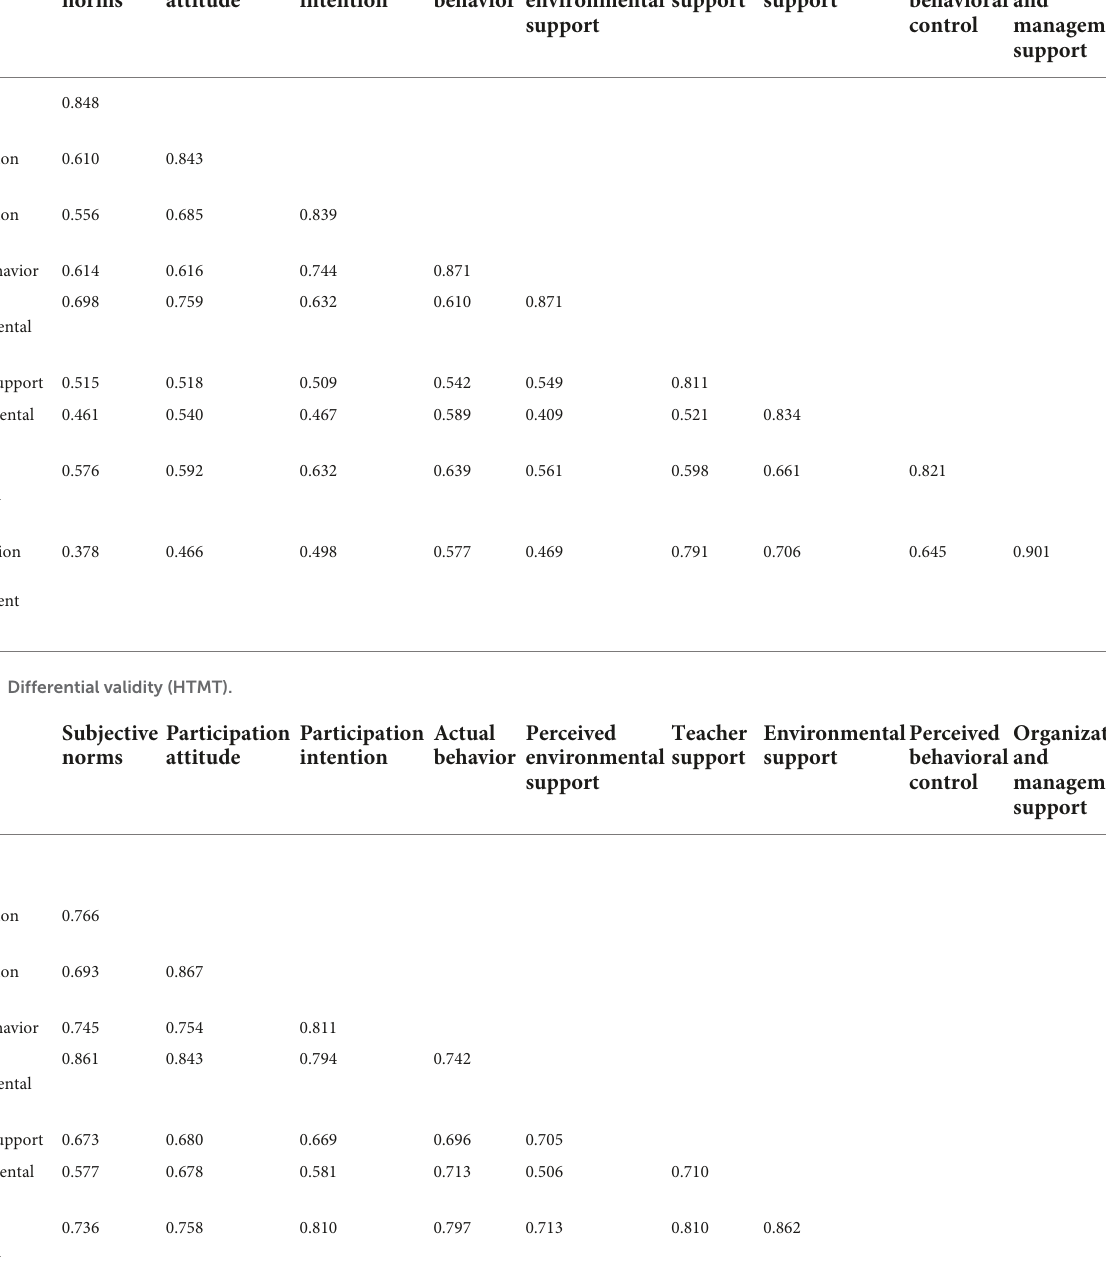
TABLE 5 Discriminant validity (Fornell and Larcker, 1981).